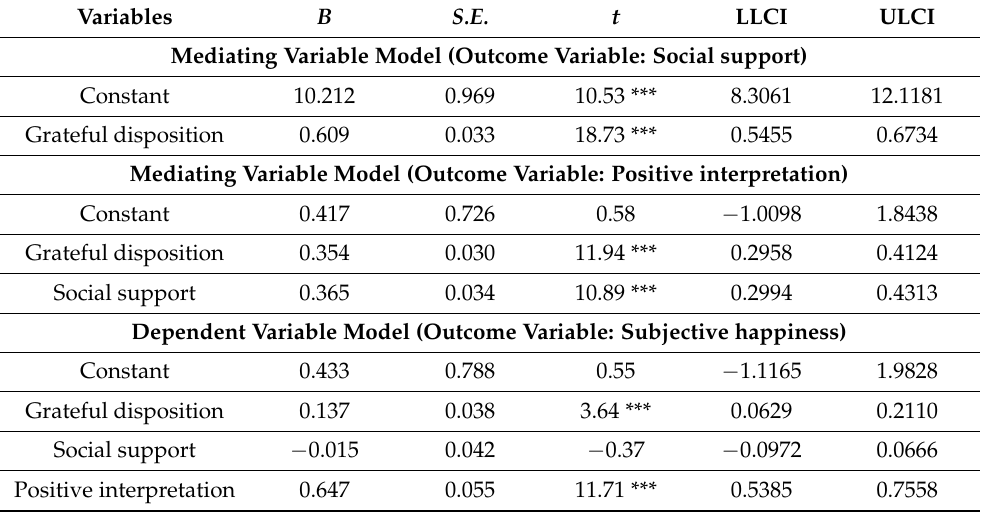
Table 3. Double mediating effect of social support and positive interpretation on grateful disposition and subjective happiness.